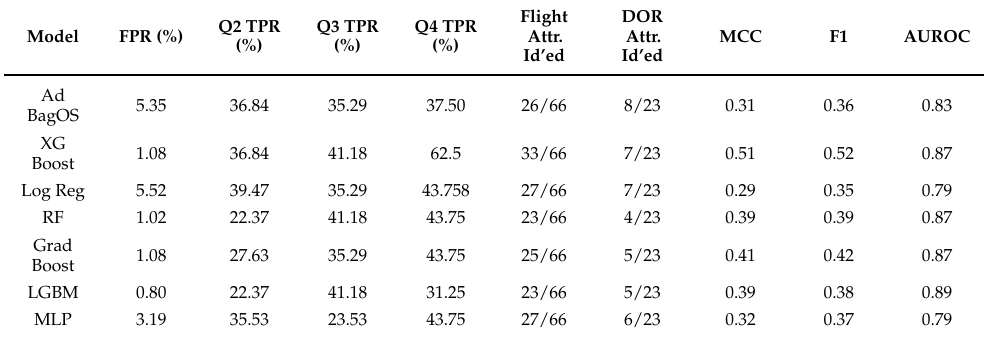
Table 2. Performance of ML models identifying primary stage attrition using PRI Q-1